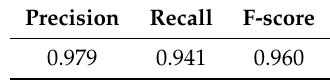
Table 14. Katayama’s transcription evaluated against Kirikae’s transcription.